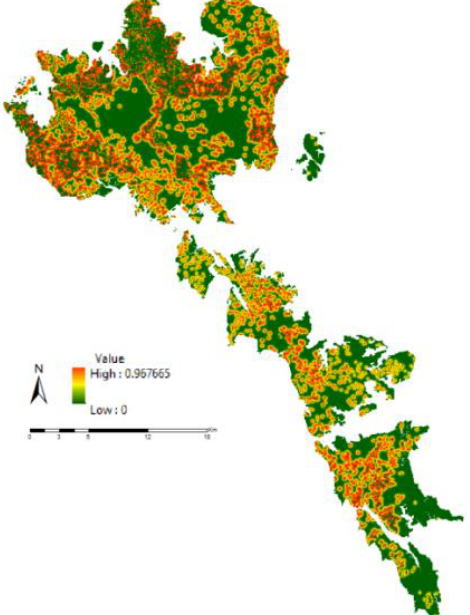
Figure 2. Transition potential map of FTZ